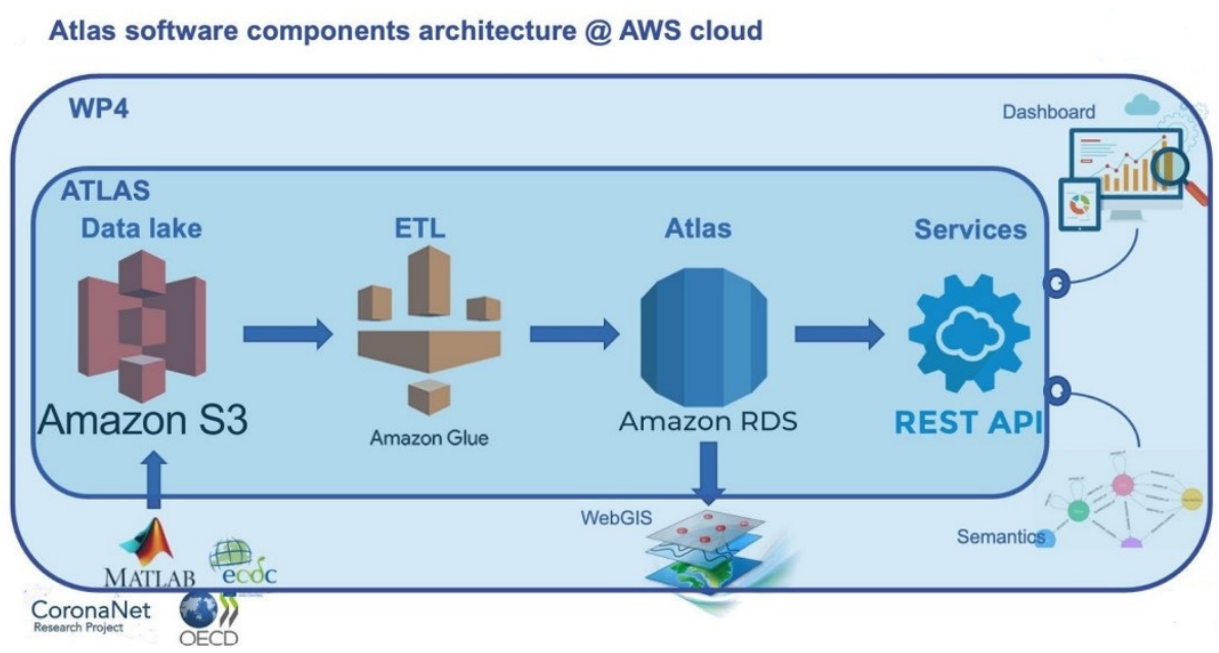
Figure 3. Software components of the Atlas.